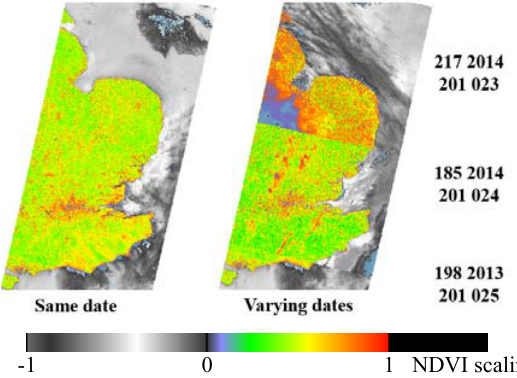
Figure 2. Mosaicking Landsat 8 scenes from the same date (left) and differencing dates (right, with the day of year / year and path / row listed for each of the three scenes). The colour bar underneath shows how the NDVI values are mapped: shades of grey for negative values and then blue to green to yellow to orange to red for positive